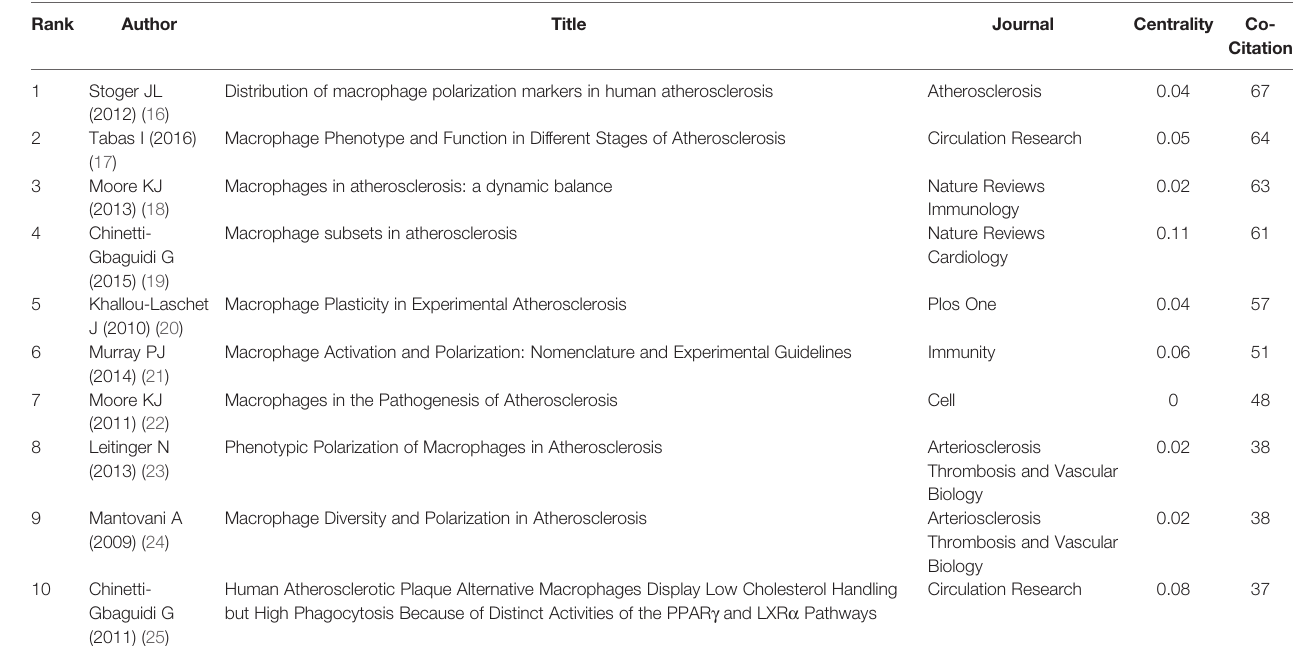
TABLE 6 | Top 10 co-cited references for macrophage polarization research in